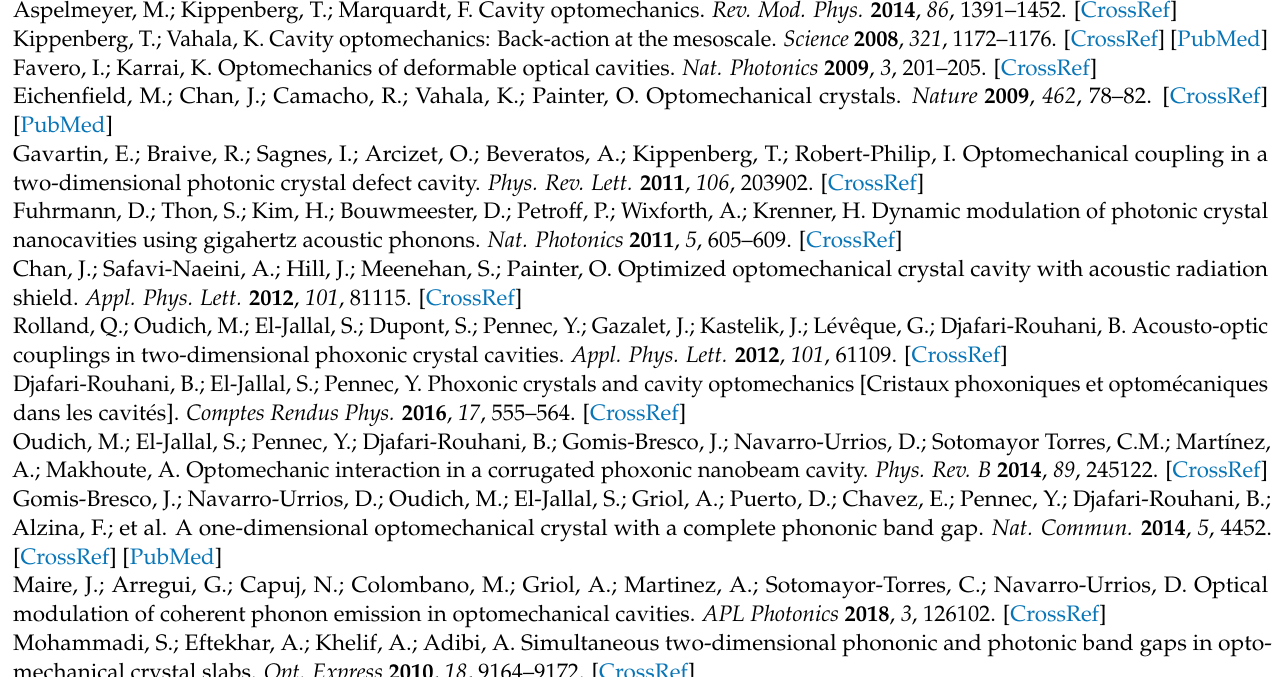
Figure A2. Spatial distribution of the x -component of the Poynting vector in a corrugated nanobeam with two cavities in shape A separated by 9 perfect unit cells (“ − o 4 × o 9 × o 4 − ”) for four temporal phaseshifts: 0 ( a ), π /2 ( b ), π ( c ) and 3 π /2 ( d ).